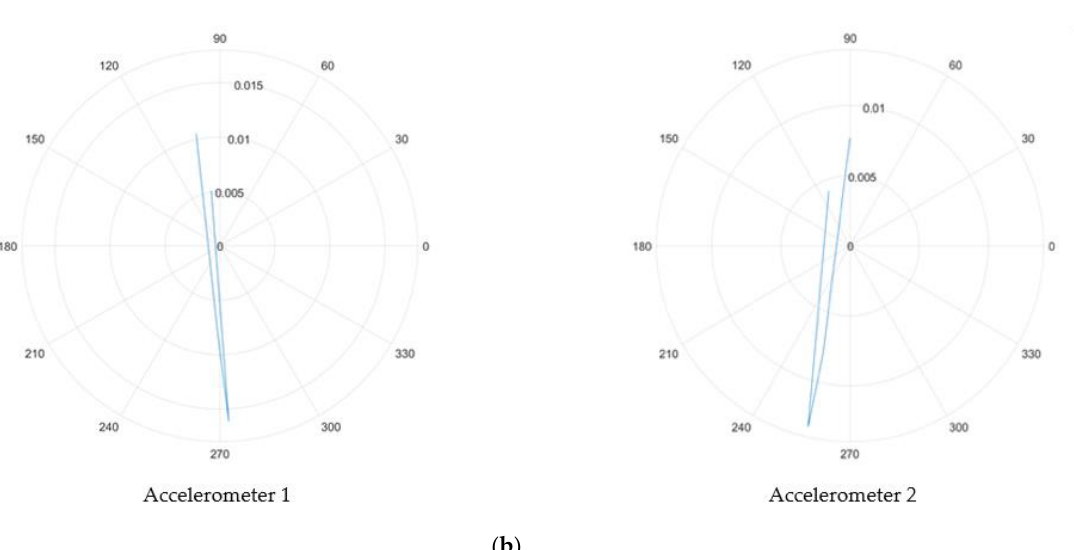
Figure 9. Hodogram analysis for the microcrack of the plain SCC beam: ( a ) amplitude–time curves highlighting the analysed section, and ( b ) hodograms for the microcrack.